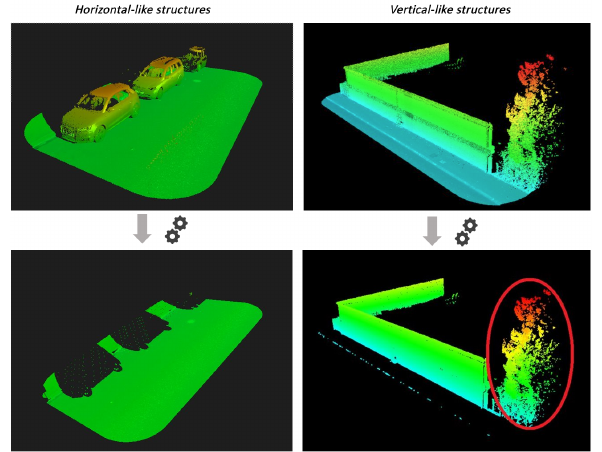
Figure 5. RANSAC applied to the extent shrunken using semantics of existing